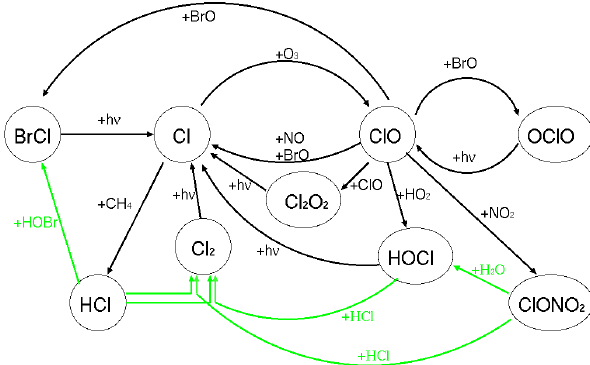
Fig. 10. Schematic of the chemical reaction system governing chlo- rine partitioning in ClaMS. Green arrows denote heterogeneous re-